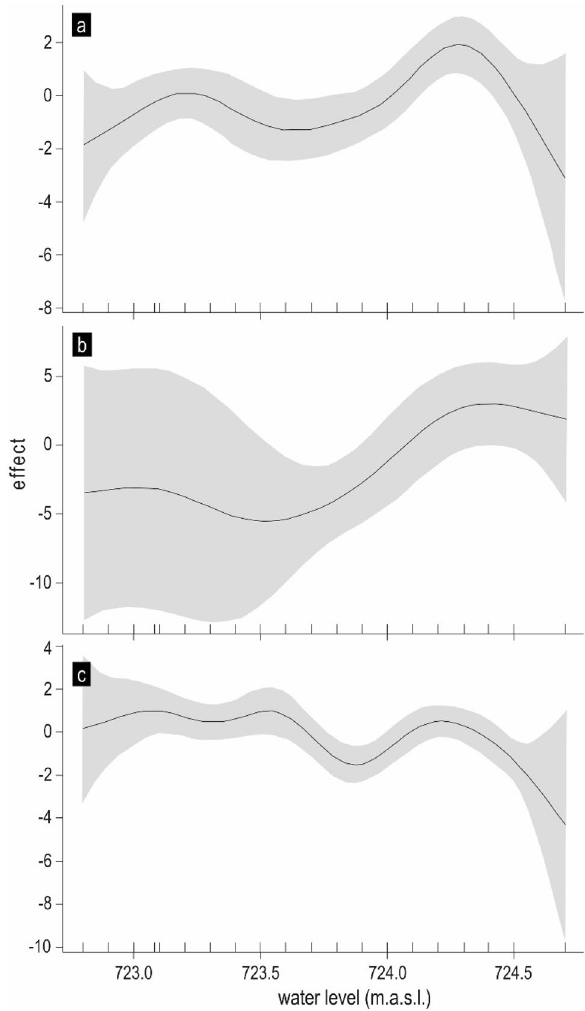
Figure 5. Effect of water level on the probability of L. idus ( a ), L. aspius ( b ) and S. cephalus ( c ) occurrence in the tributary. The solid line is an estimate of s level ; the shaded region shows (pointwise constructed) 95% confidence intervals for given water level